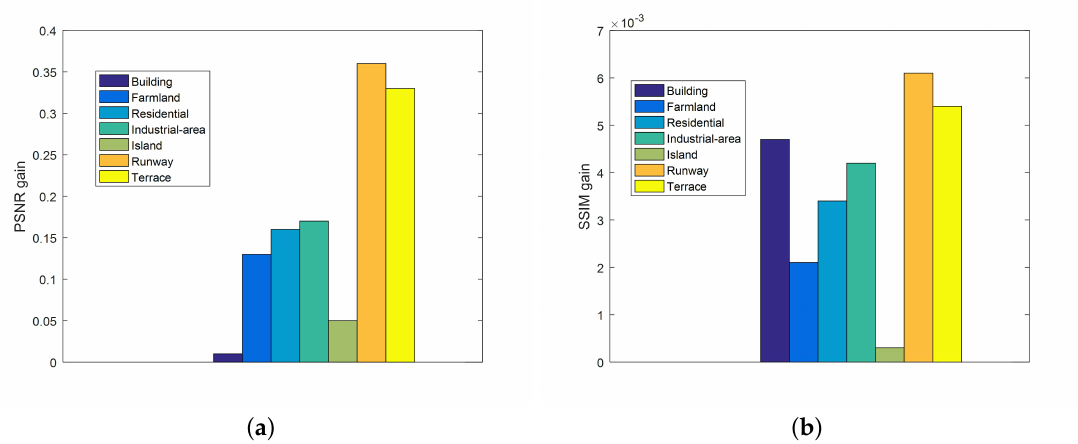
Figure 9. Peak Signal-to-noise Ratio(PSNR) and Structural Similarity Index(SSIM) gains of the method with adaptive parameters over the method with fixed parameters. ( a ) PSNR gains. ( b ) SSIM